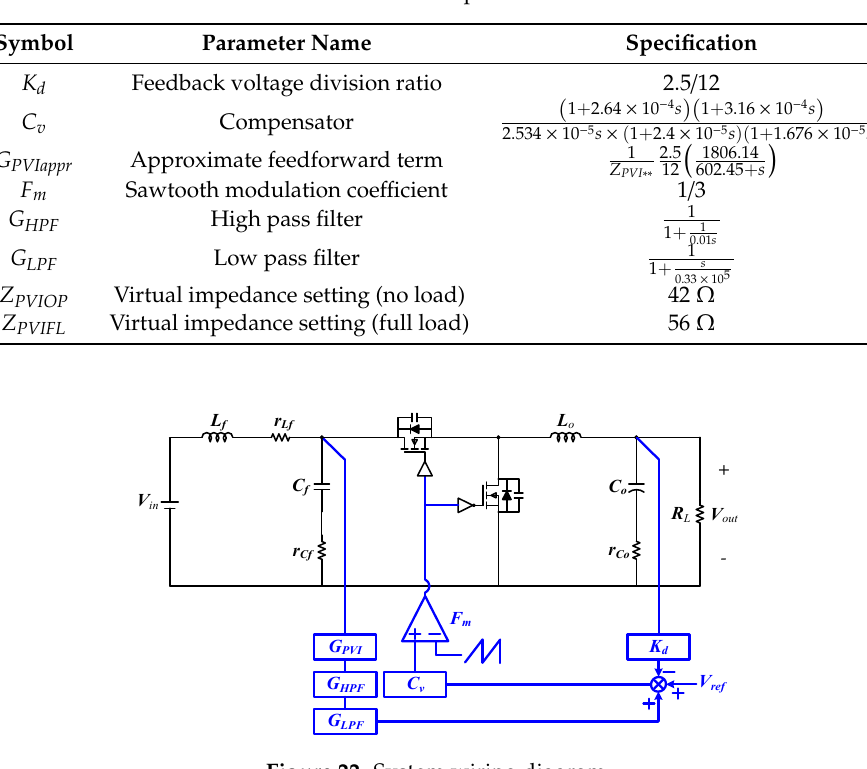
Figure 22. System wiring diagram.